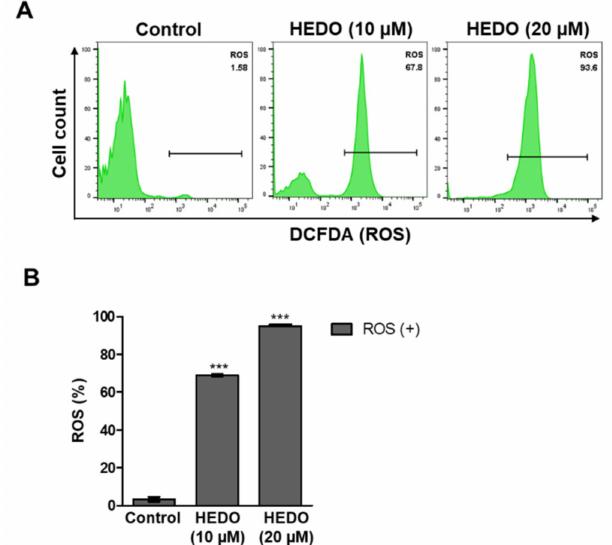
Figure 4. HEDO-induced changes in intracellular reactive oxygen species (ROS) levels in OCI-LY3 cells. ( A ) Measurement of ROS levels through flow cytometry with 2 (cid:48) ,7 (cid:48) -dichlorodihydrofluorescein diacetate assay (H 2 DCFDA) (1 µ M). ( B ) Quantified ROS levels. Values indicate the means ± SEM. (n = 3, *** p ≤